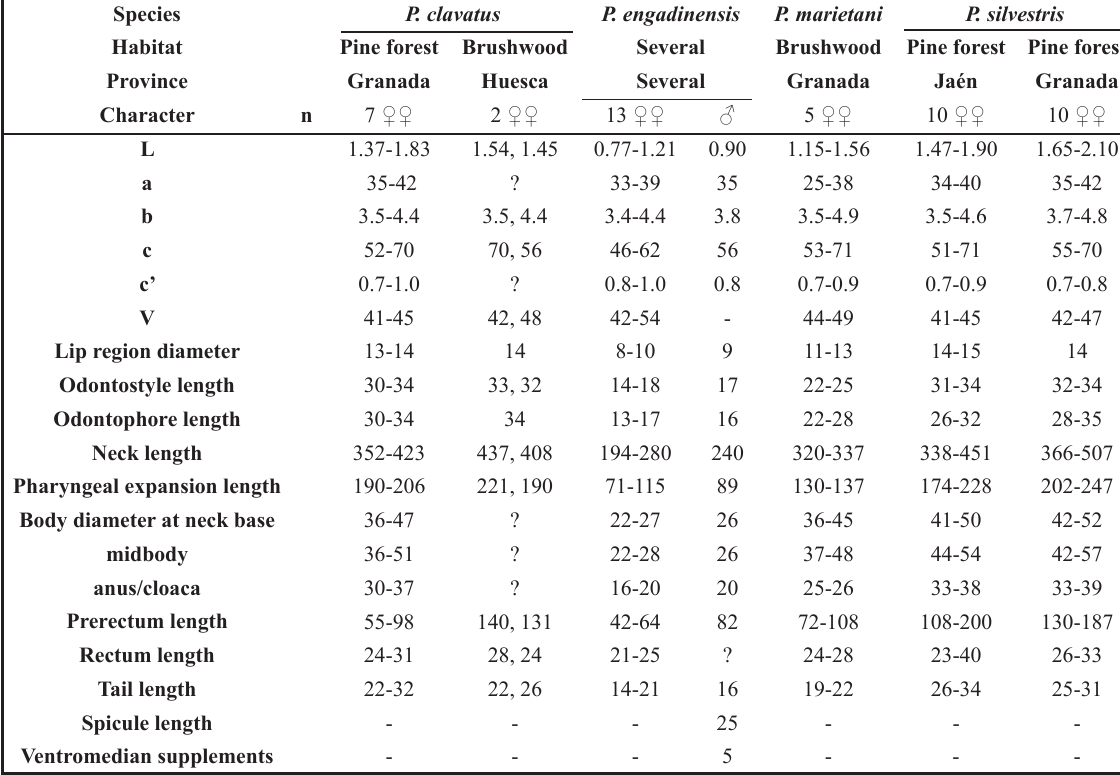
Table 1. Morphometrics of Iberian populations of the genus Pungentus Thorne & Swanger, 1936. Measurements in μm (except L, in